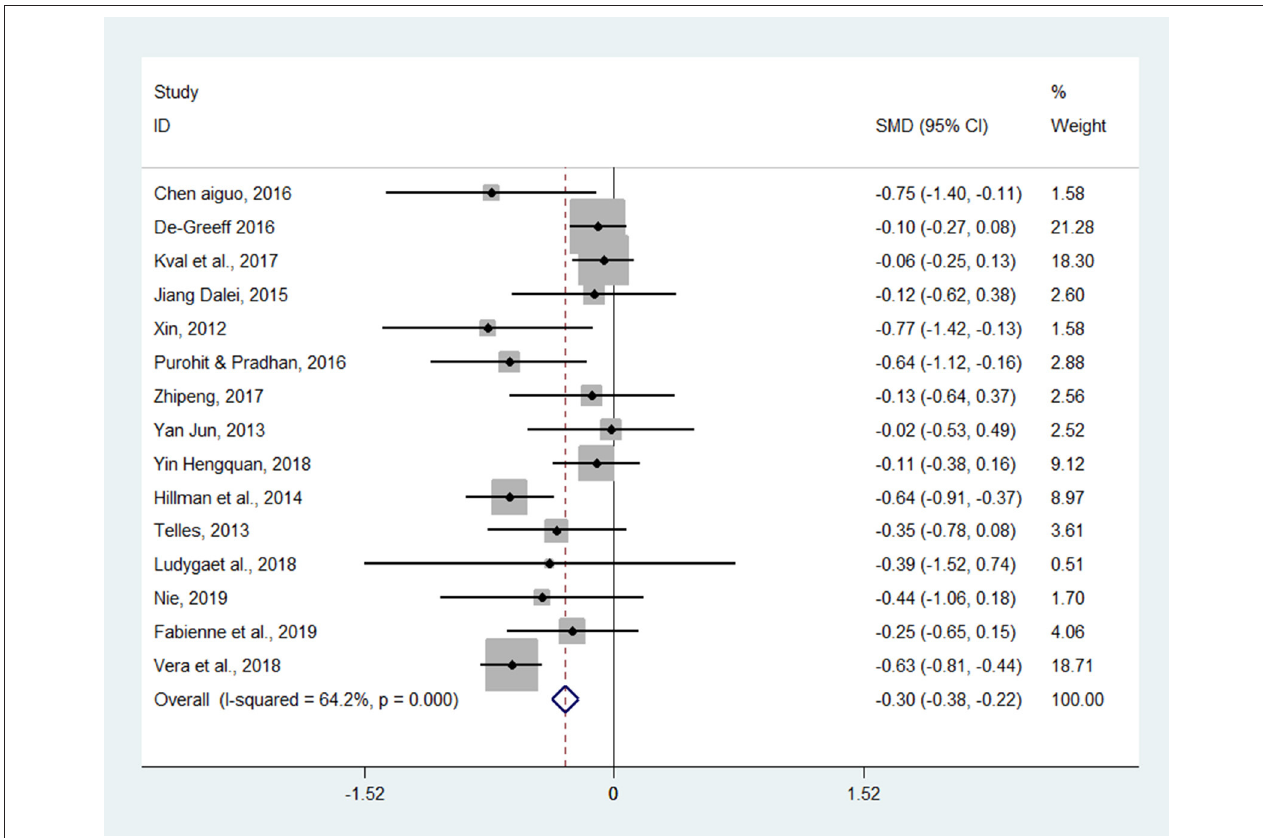
FIGURE 3 | The effect of chronic exercises on inhibitory control (SMD = standardized mean difference; CI = confidence